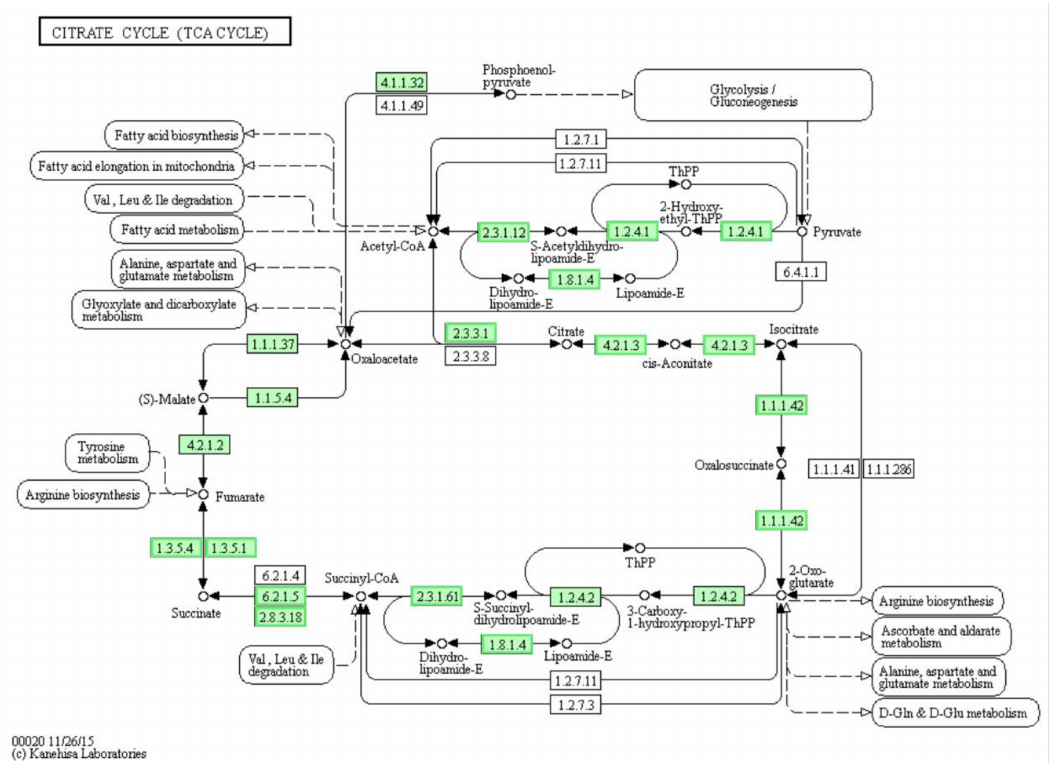
Figure 5. Significantly enriched KEGG pathway “Citrate cycle (TCA cycle)”; (from KEGG database, green rectangles represent proved organism-specific gene product and green frames represent down-regulation and red frames represent